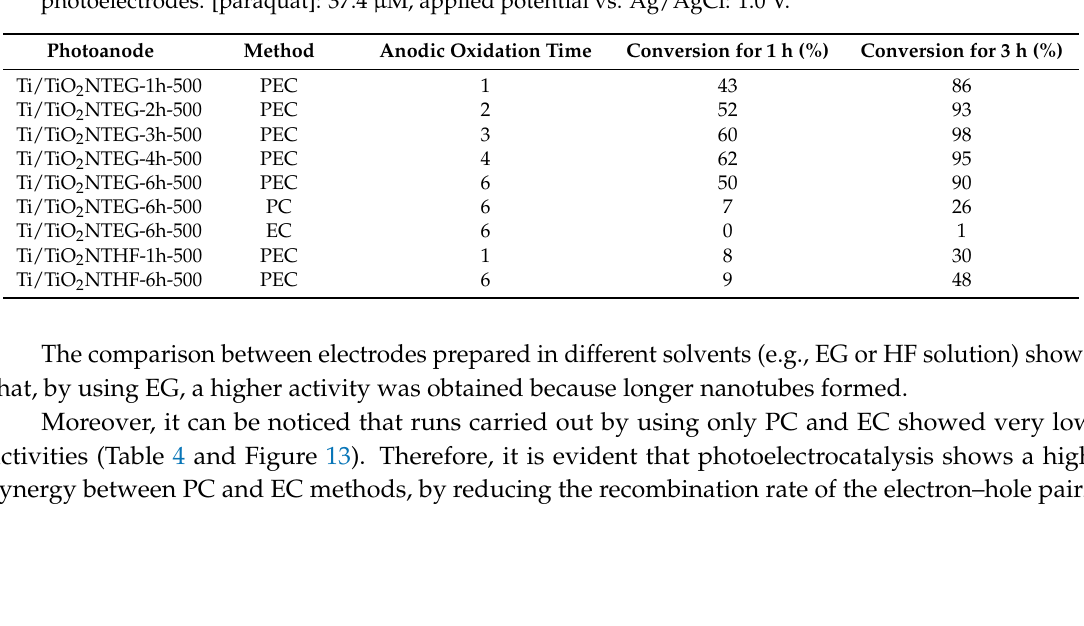
Table 4. The results of PEC, PC and EC paraquat degradation by using Ti/TiO 2